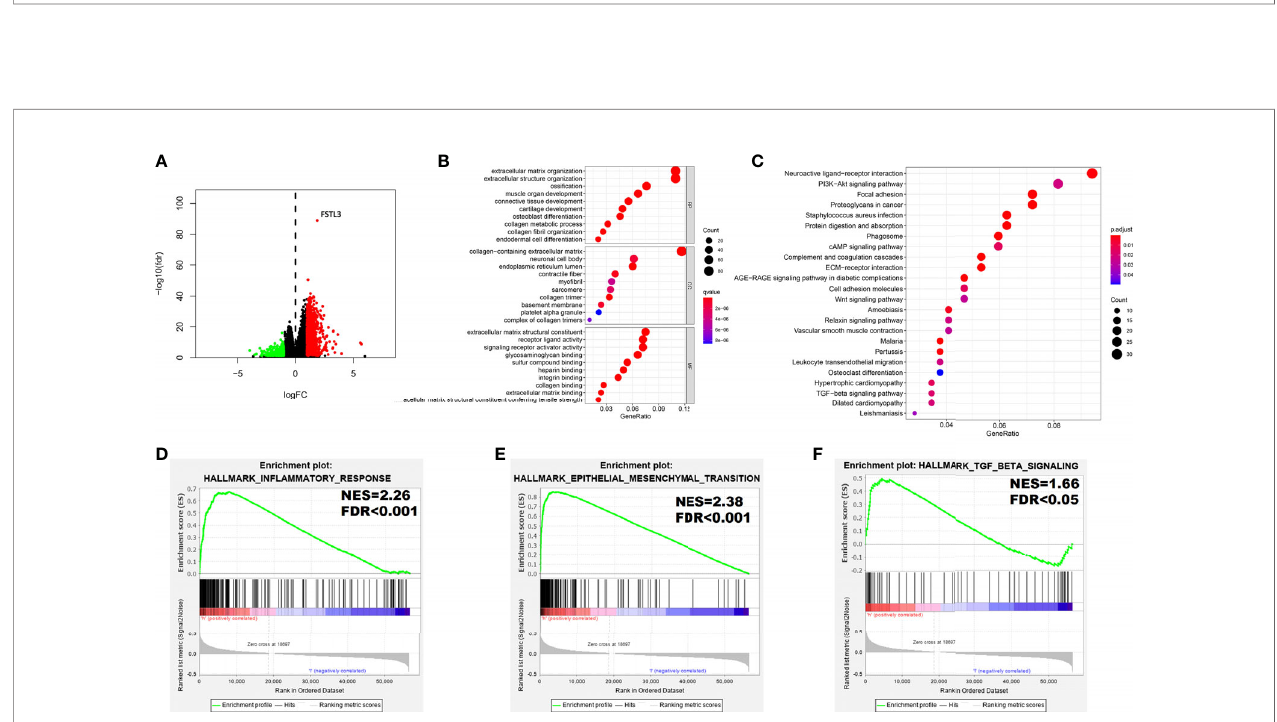
FIGURE 8 | Functional Annotation among the High and Low FSTL3 Expression Groups. (A) The volcano plot showed that 1,331 differential genes were identi fi ed between high and low FSTL3 groups. Each red dot represents upregulation gene, each green dot represents upregulation downregulation gene, and each black dot represents no signi fi cant difference genes. (B) The top 10 signi fi cant terms of GO analysis. (C) The top 20 signi fi cant pathways of KEGG analysis. (D – F) The GSEA showed that in fl ammatory response (D) , epithelial – mesenchymal-transition (E) , and TGF- b signaling (F) were positively enriched in FSTL3 high-expression